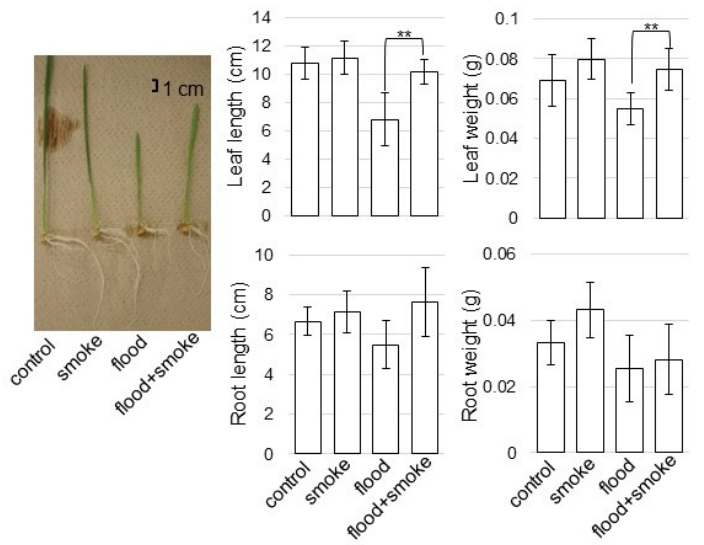
Figure 2. The morphological effects of the plant-derived smoke solution on wheat under flooding stress. Wheat seeds were sown and treated with or without 2000 ppm of the plant-derived smoke solution. Three-day-old wheats were treated with or without flooding for three days. As morpho- logical parameters, leaf length, leaf-fresh weight, main-root length, and total-root fresh weight were analyzed 6 days after sowing. The bar in the left panel indicates 1 cm in the picture. The data are presented as mean ± SD from three independent biological replicates. Asterisks indicate significant changes between wheats treated with the plant-derived smoke solution under flooding and with only flooding according to the Student’s t -test (**: p < 0.01).